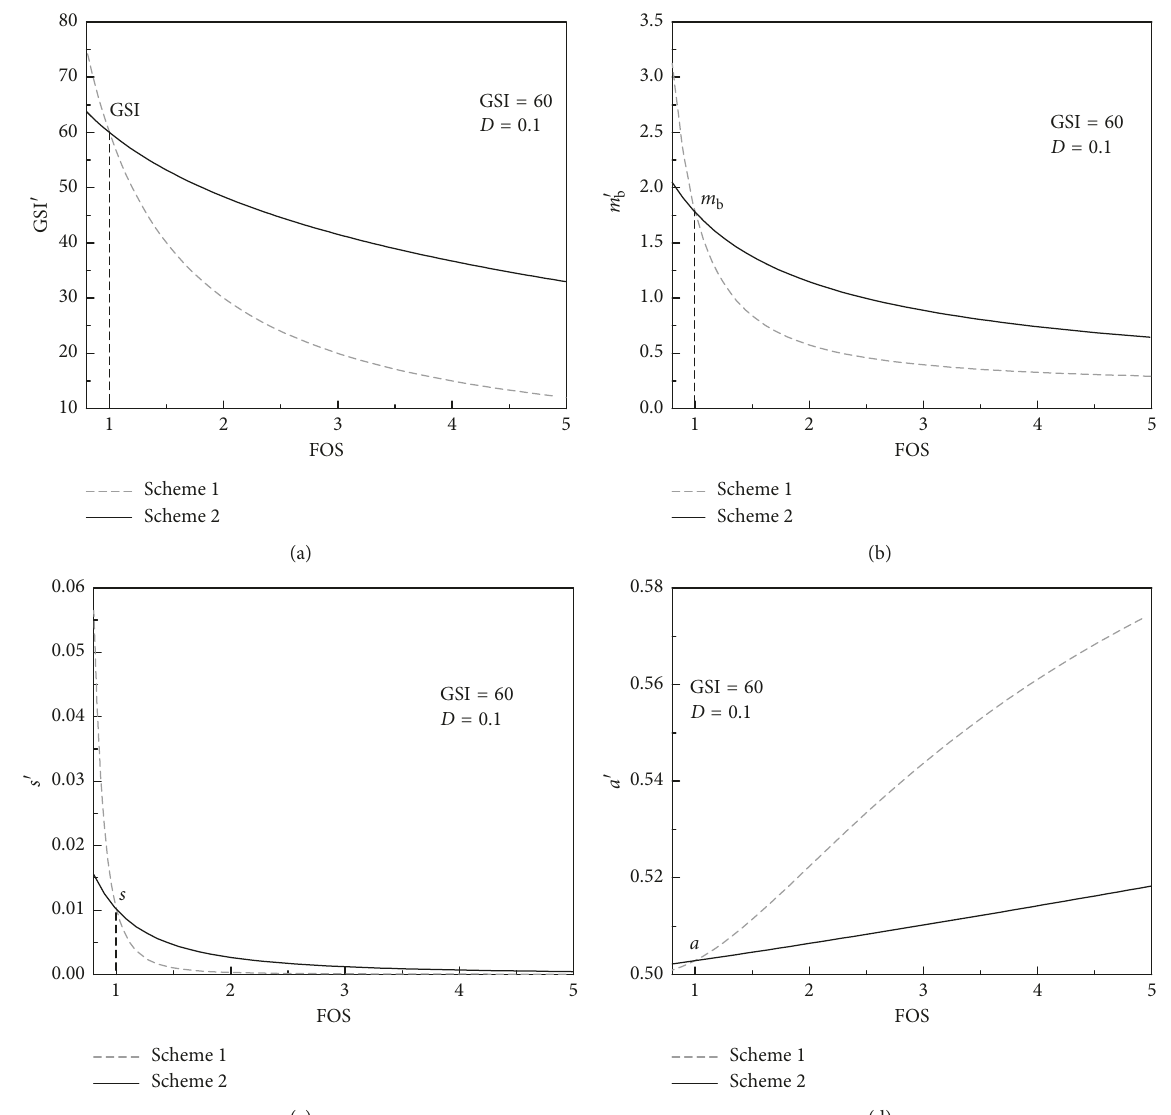
Figure 3: The relationship between (a)